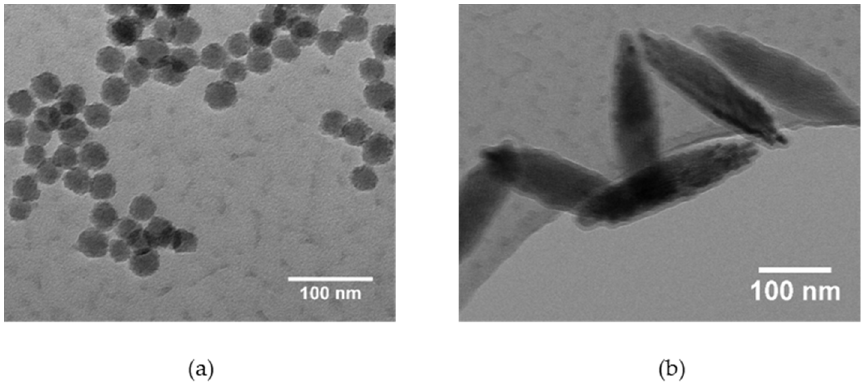
Figure 2. TEM image of ( a ) SiO 2 particles and ( b ) SiO 2 @ α -Fe 2 O 3 particles.